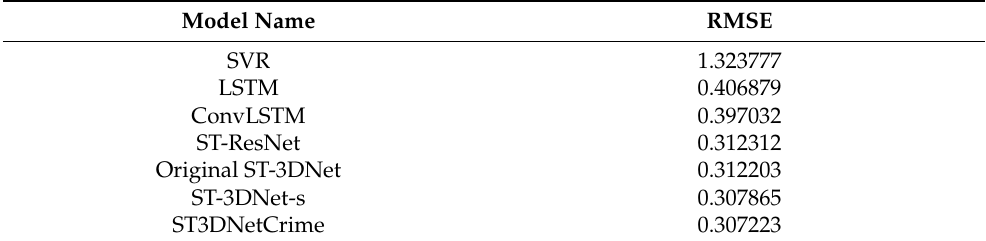
Table 1. Comparison between different models in terms of